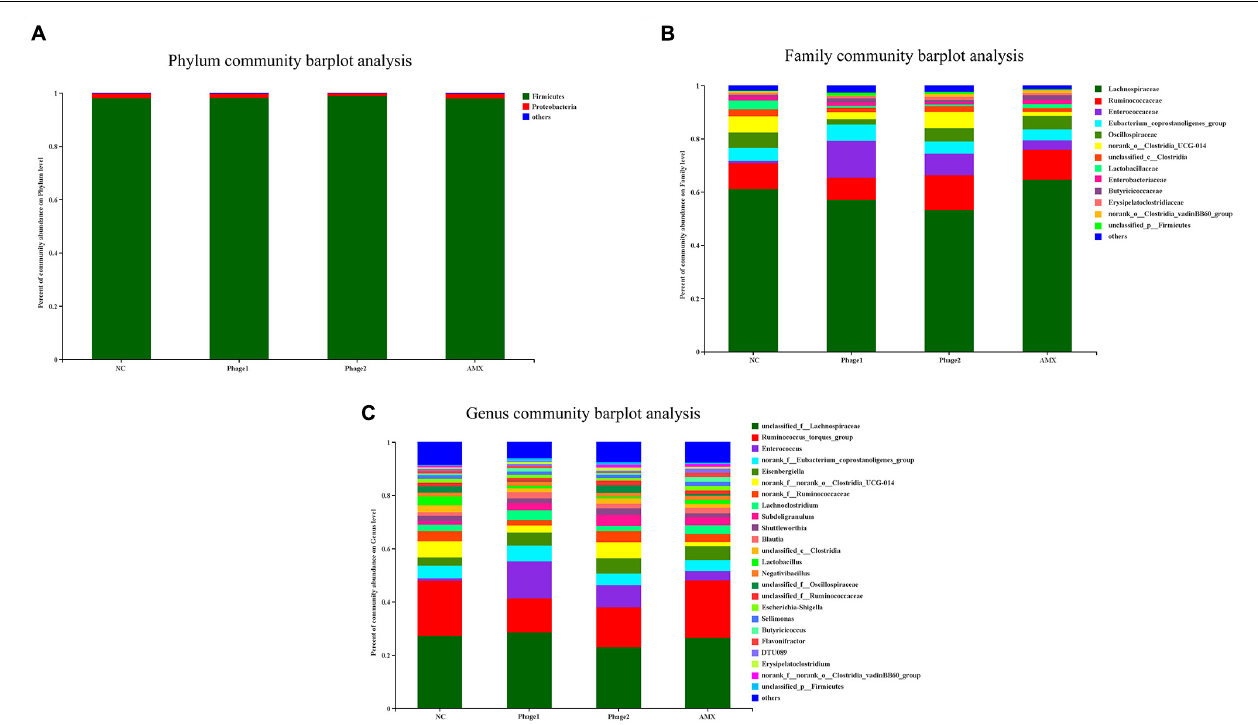
FIGURE 7 | Effect of phages on the microbiota composition in the cecal digesta at different taxonomic levels (A) at phylum levels, (B) at family levels, and (C) at genus levels). Less than 1% abundance at the phylum, family, or genus level was merged with others. NC, negative control; Phage 1, 10 9 PFU GRNsp6 (day 3-5);